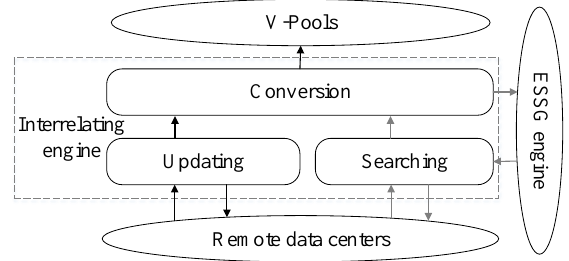
Fig.6 Architecture of interrelating engine. It is mainly composed of updating, searching and conversion components.